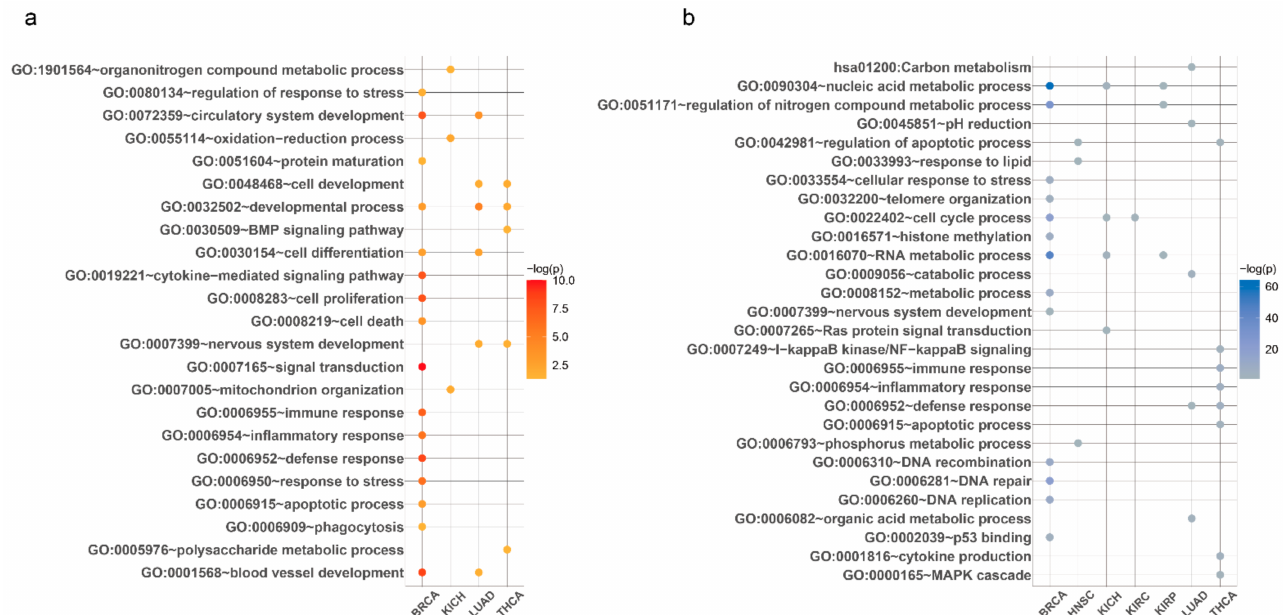
Figure A1. Examples of aging-related pathways. Representative pathways which were enriched by ( a ) increasing and ( b ) decreasing aging-related genes identified from each tissue